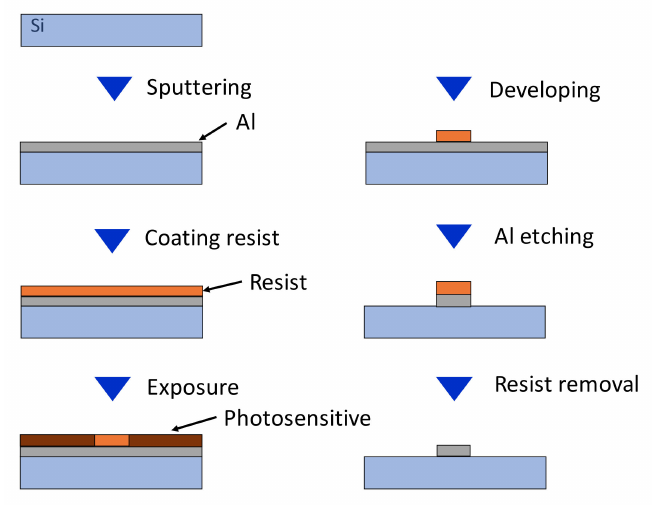
Figure 13. Circuit fabrication method by semiconductor microfabrication 1.